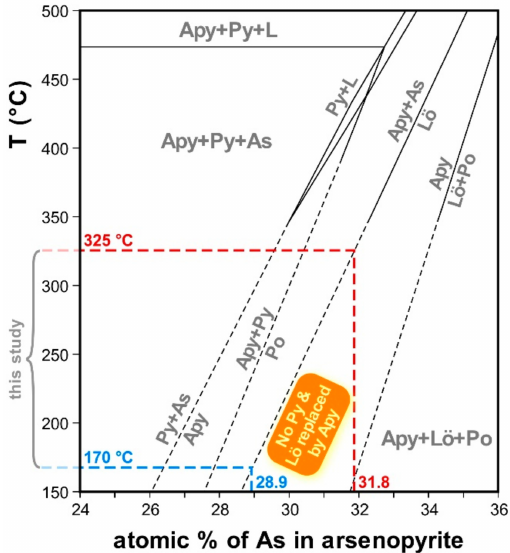
Figure 10. Arsenopyrite geothermometry based on the pseudobinary T-X diagram of Reference [28] for the Poop ó deposits. The range of temperatures was obtained by using the EPMA analysed of arsenopyrite in Table S1, plotted against the arsenopyrite + arsenic / löllingite boundary considering (1) the absence of pyrite in association with arsenopyrite, (2) the sequence that determines that löllingite was replaced by arsenopyrite, and (3) pyrrhotite was passively precipitated on arsenopyrite, and then replaced by pyrite. The löllingite → arsenopyrite → pyrrhotite → pyrite sequence denotes an increasing availability of sulphur in the environment or a temperature rise (e.g., Figure 16 in Reference [5]). Key: Apy = arsenopyrite, As = native arsenic, L = liquid, Lö = löllingite, Po = pyrrhotite, Py =